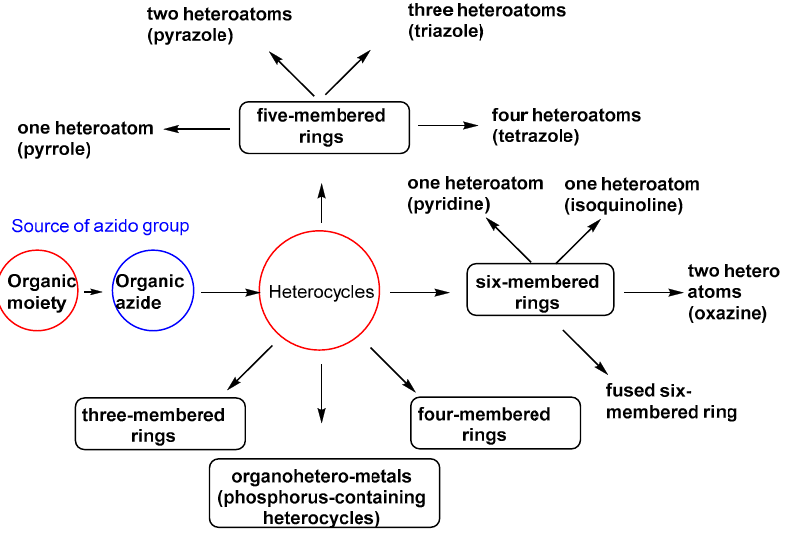
Figure 2. Contribution of organic azides in heterocyclic synthesis, exemplary cases of the heterocycles .